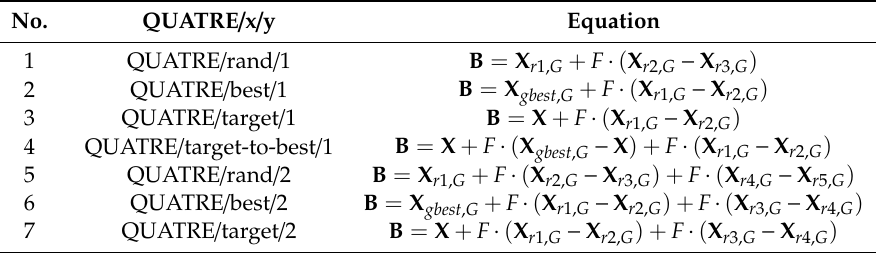
Table 1. The seven schemes of donor matrix B